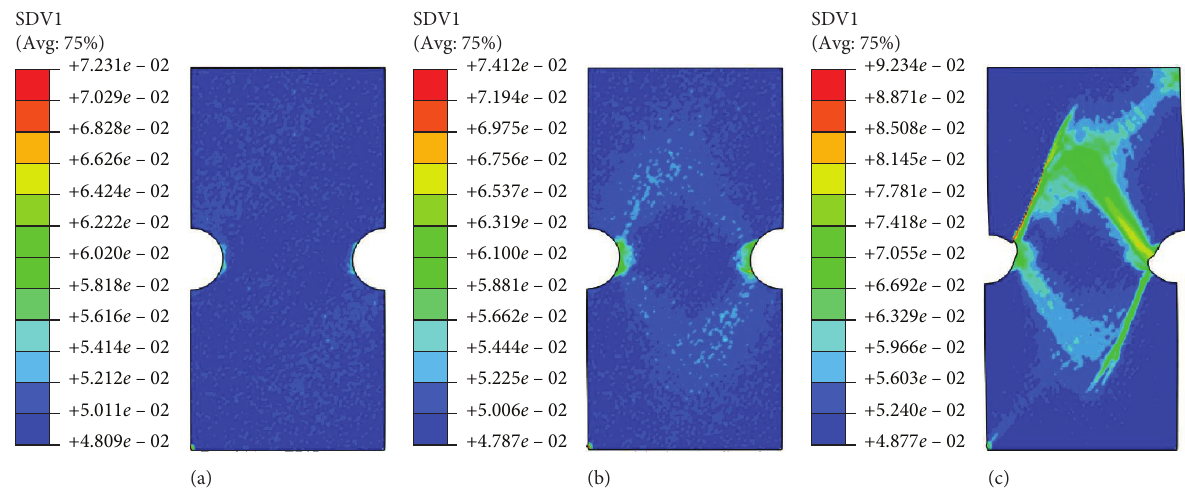
Figure 7: Shear banding illustration of free-volume localization for specimen D under different compressive strain levels. (a) ε � 1.44%; (b) ε � 2.08%; (c) ε � 5.0%.